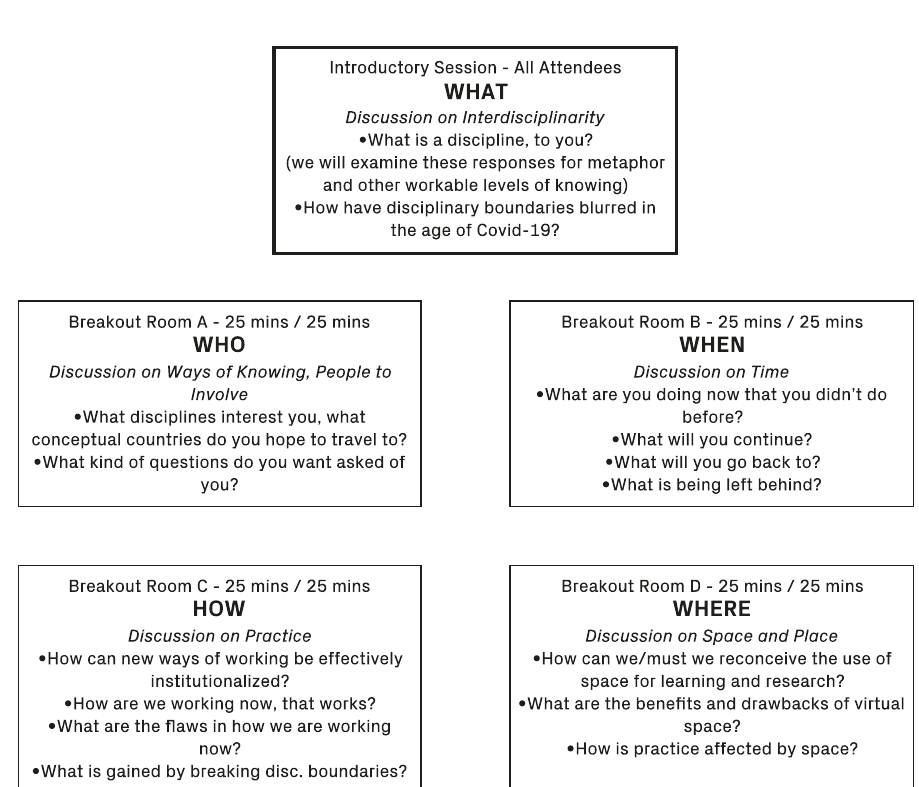
Fig. 2 Outline of the charrette structure through which we examined research and interdisciplinarity. The charrette consisted of an introduction session of 50 min, two breakout sessions of 25 min each, and a report session of 30 min, conducted June 15, 2020. The conversations were recorded, transcribed and analyzed as shown in Figs. 3 and